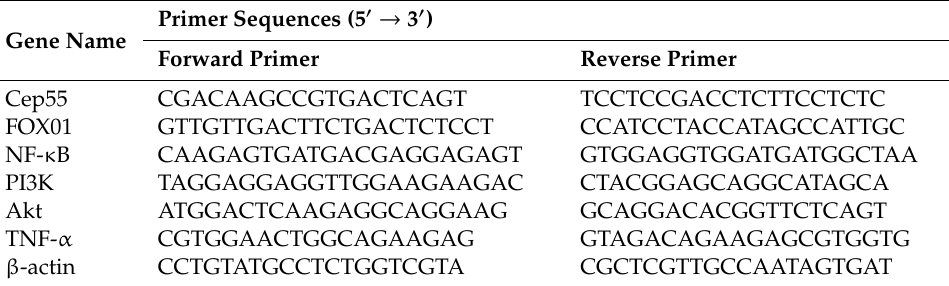
Table 2. Primers of the genes in q-PCR